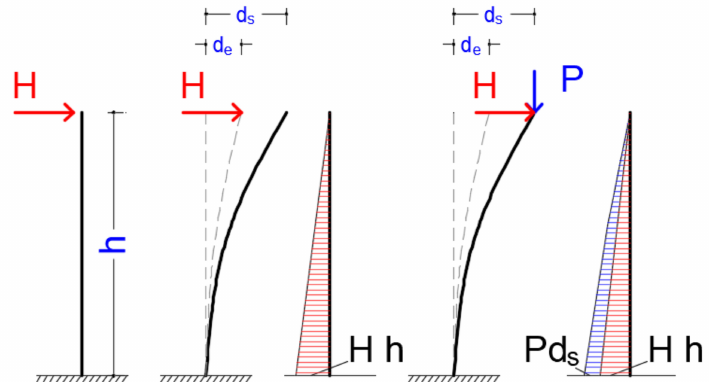
Figure 3. Static equilibrium of a cantilever in the deformed